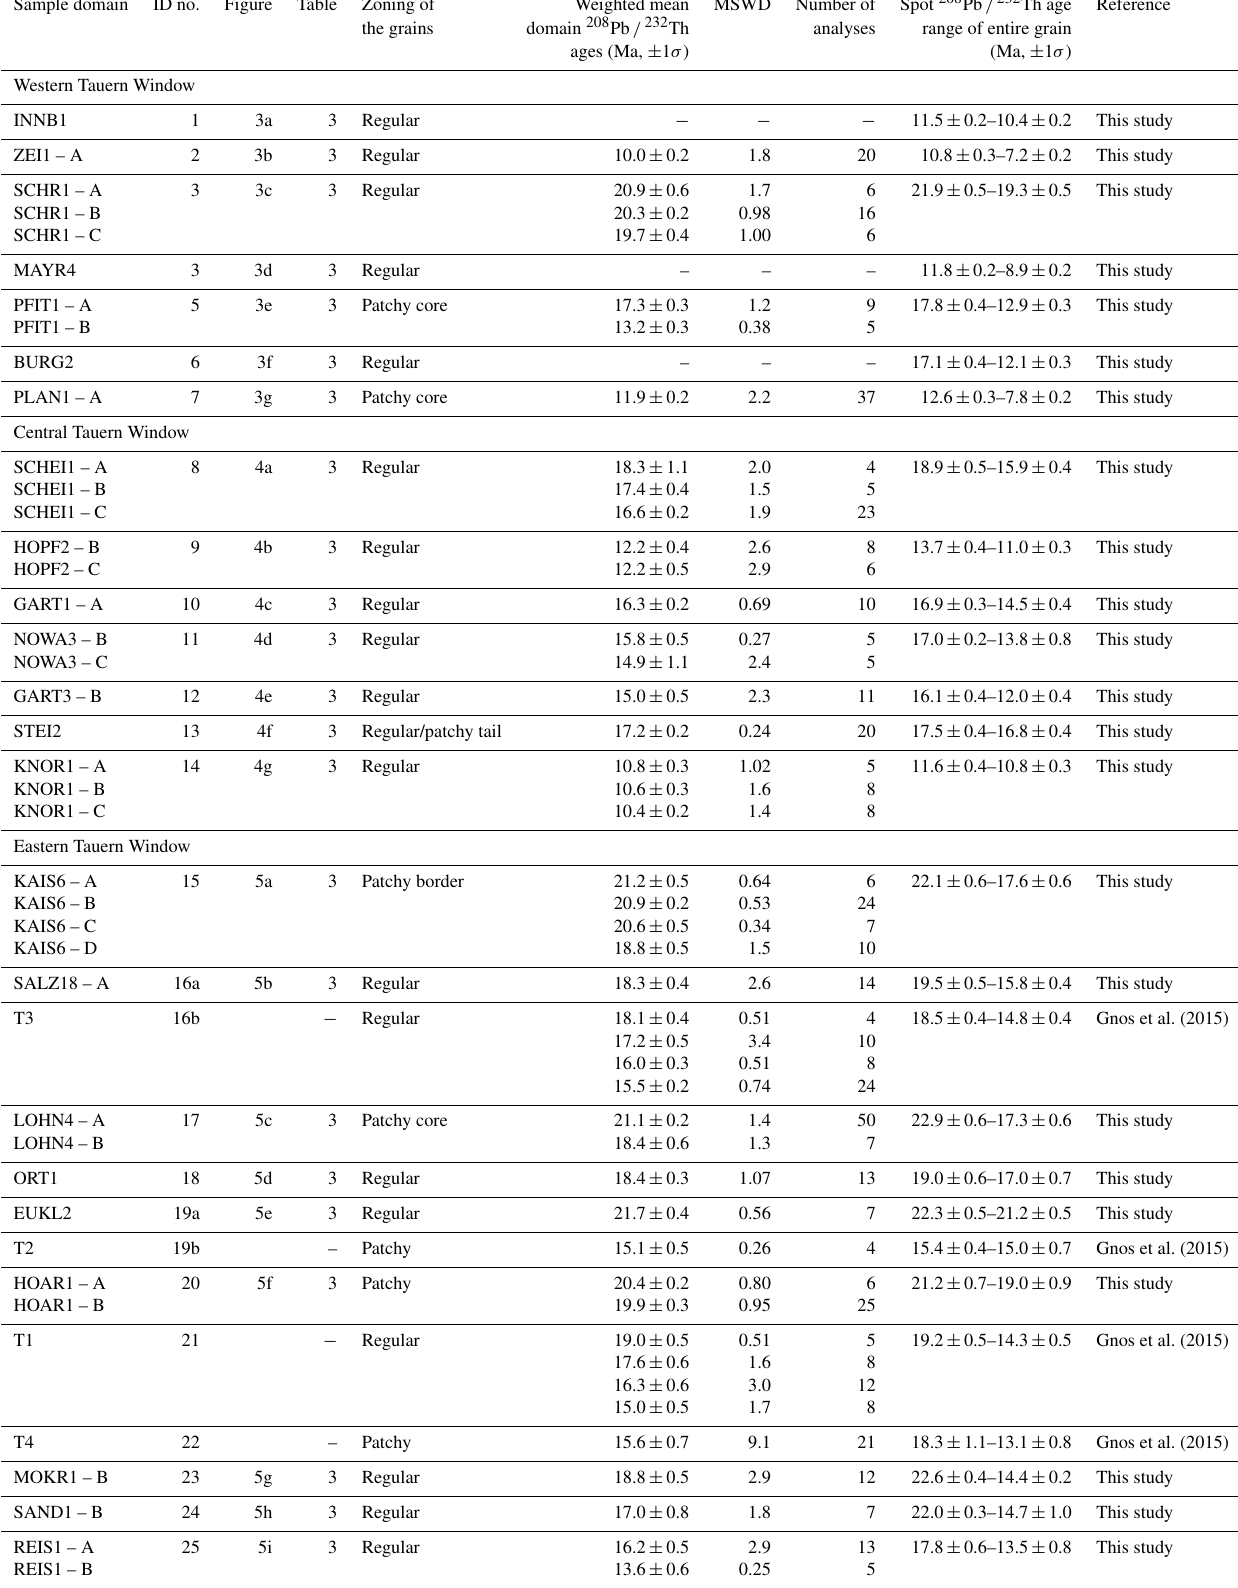
Table 4. Summary of weighted mean ages of monazite growth domains and spot age ranges of each grain from the TW. Sample domain ID no. Figure Table Zoning